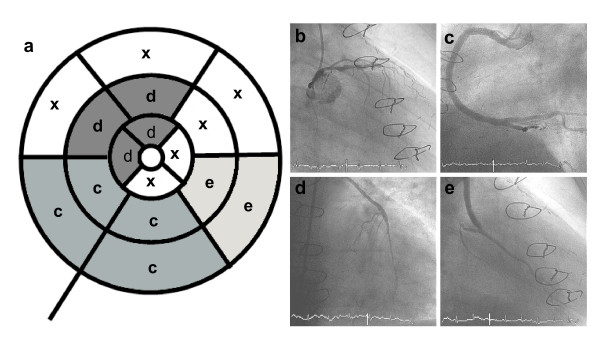
Example of the selection of the perfusion territories as retrospectively defined by angiography. On the left side (a) the polar map (three short axis slices, 16 segment model) with the segments included in the analysis according to angiography. The letters on the polar map correspond to those on the angiographic images. Segments marked with an "x" were not used for analysis, as care was taken to include segments with a very high probability of being supplied by the vessel/graft only. The proximal LAD (b) was not included for analysis, as the basal short axis view is planned to exclude the left ventricular outflow tract and may therefore not include the very basal anterior wall. The anterolateral segments (apical and medial) were not included due to the lack of visible distal diagonal branches. There is a large right coronary artery without significant stenosis (c), the LIMA graft on the distal LAD (d) and a venous bypass on a marginal branch (e).